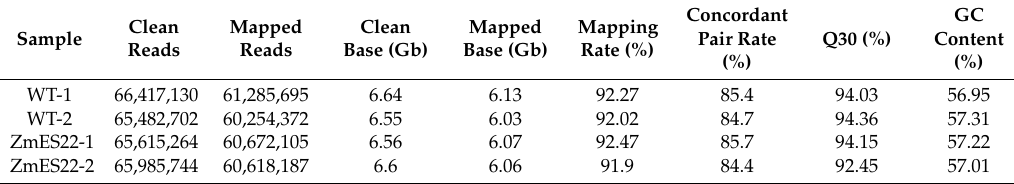
Figure 7. Expression profiles of 17 starch synthesis related genes across diverse developmental stages. Blue line represents wild type (Zhonghua 11), and red line denotes transgenic lines. d is short for days after pollination (DAP). The mRNA expression level of each gene in the three DAP seeds of wild type was used as a control. All data are shown as means ± SD from three biological replicates and two technical replicates. Primers are listed in Supplemental Table S3. Table 1. Statistics of sequencing